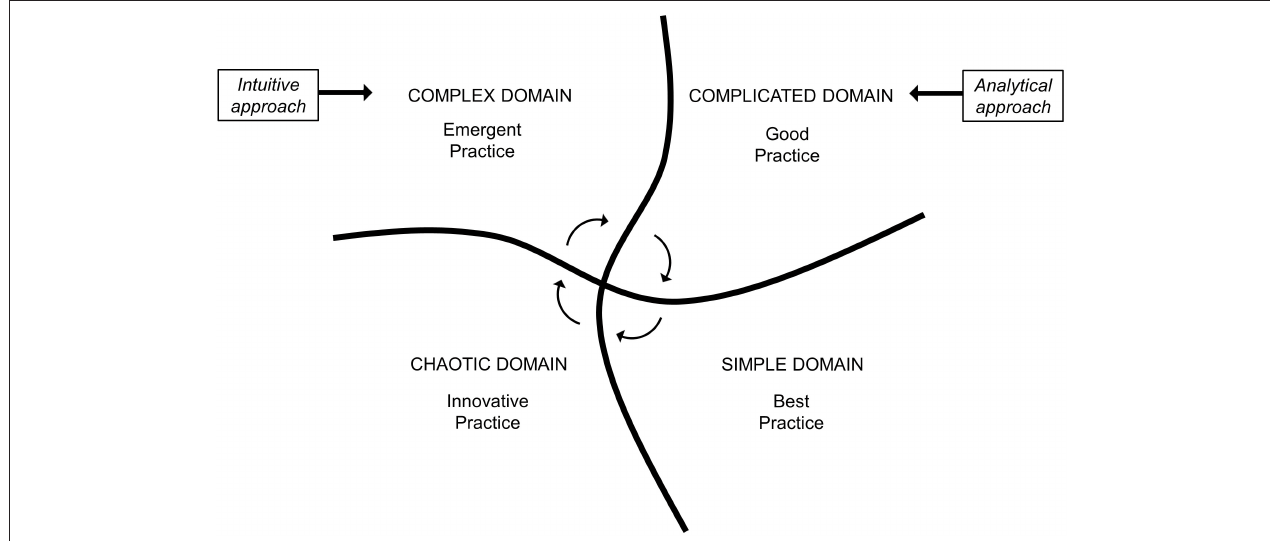
FIGURE 1 | Cynefin identifies four different domains of medical knowledge. Each of them consents different standards of clinical practice and generates circular fluxes of knowledge. Different domains require different diagnostic approaches. Adapted and modified from Snowden & Boone (